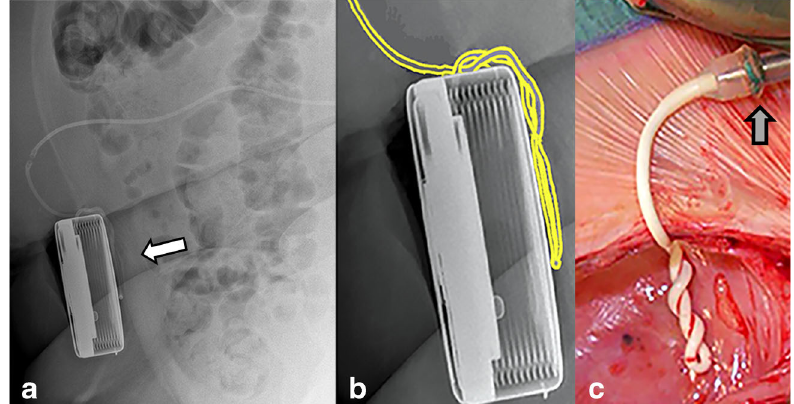
Fig. 8 Twiddler ’ s syndrome with signs of withdrawal syndrome in a 51- year-old woman with dystonia in complex regional pain syndrome. A repeatedly twisted old type catheter is visible on lateral plain radiography